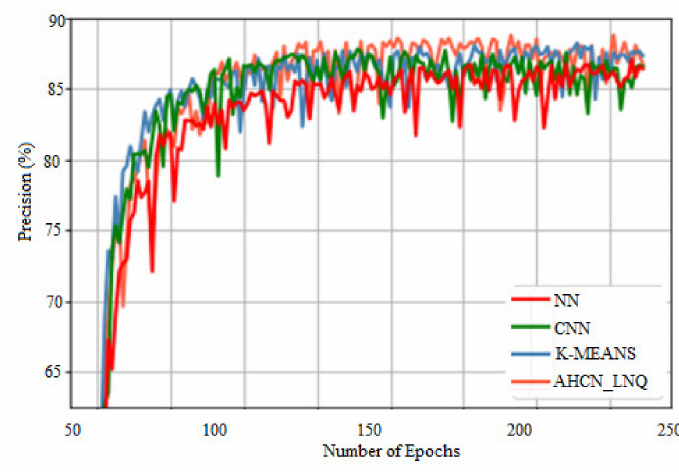
Figure 6. Comparison of